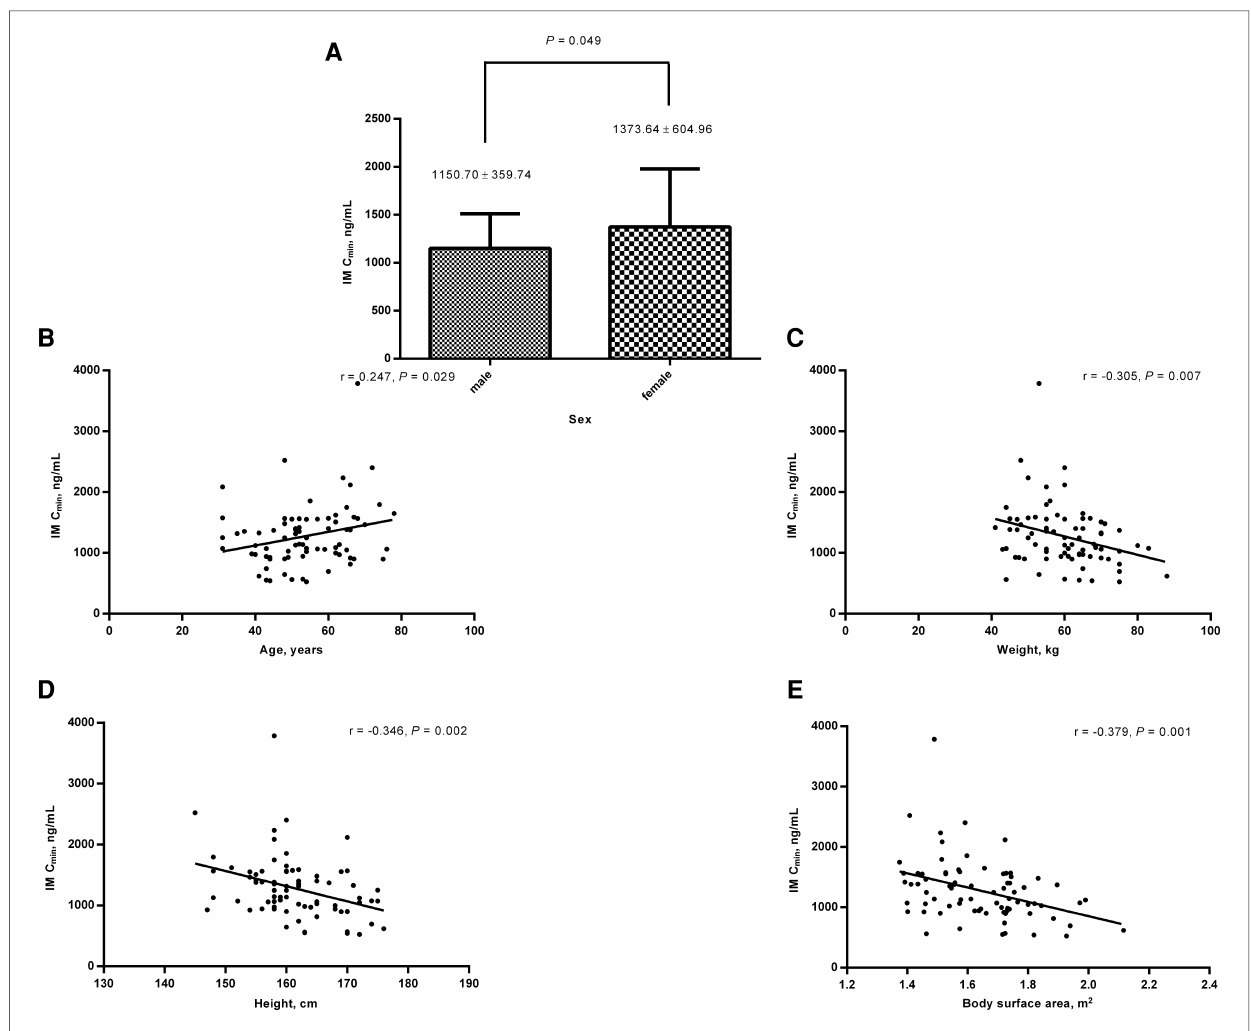
FIGURE 3 Relationships between clinical characteristics and IM C min within the medication duration of 12 months. ( A ) IM C min was signi fi cantly higher in female patients than in male patients; IM C min correlated with age ( B ) and negatively correlated with body weight ( C ), height ( D ), and body surface area ( E ). IM, imatinib; C min , plasma trough